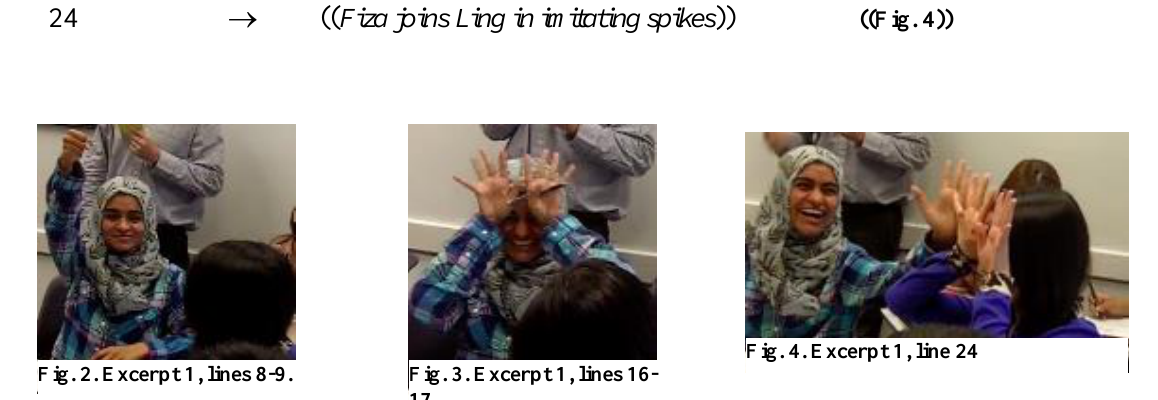
Fig. 2. Excerpt 1, lines 8-9. Fig. 3. Excerpt 1, lines 16-